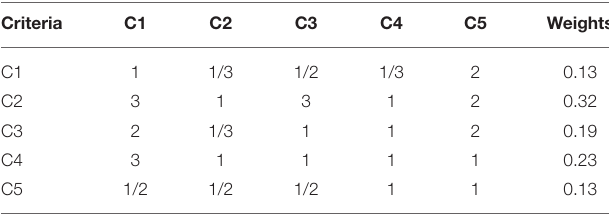
TABLE 2 | An example of pair-wise comparison matrix for assessing the weights of factors. Criteria